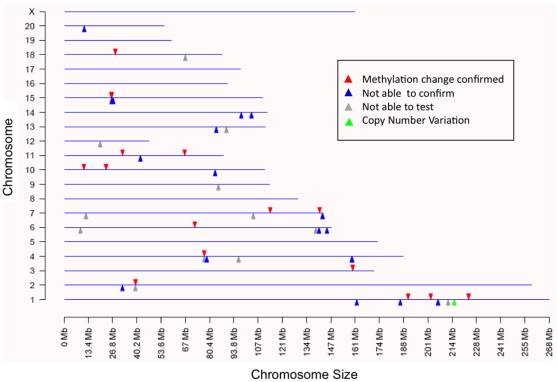
Chromosomal distribution of the transgenerational change in DNA methylation in promoter regions identified by MeDIP followed by comparative chip hybridizations.The red arrow indicates regions with confirmed methylation change through mass spectrometry. Blue arrows indicate regions in which change was not able to be confirmed, either because of insufficient CpG site measurement through mass spectrometry or not changed. Grey arrows indicate regions where primers could not be designed to test them. Green arrow indicates a transgenerational copy number variation (CNV) event in Fam111a.